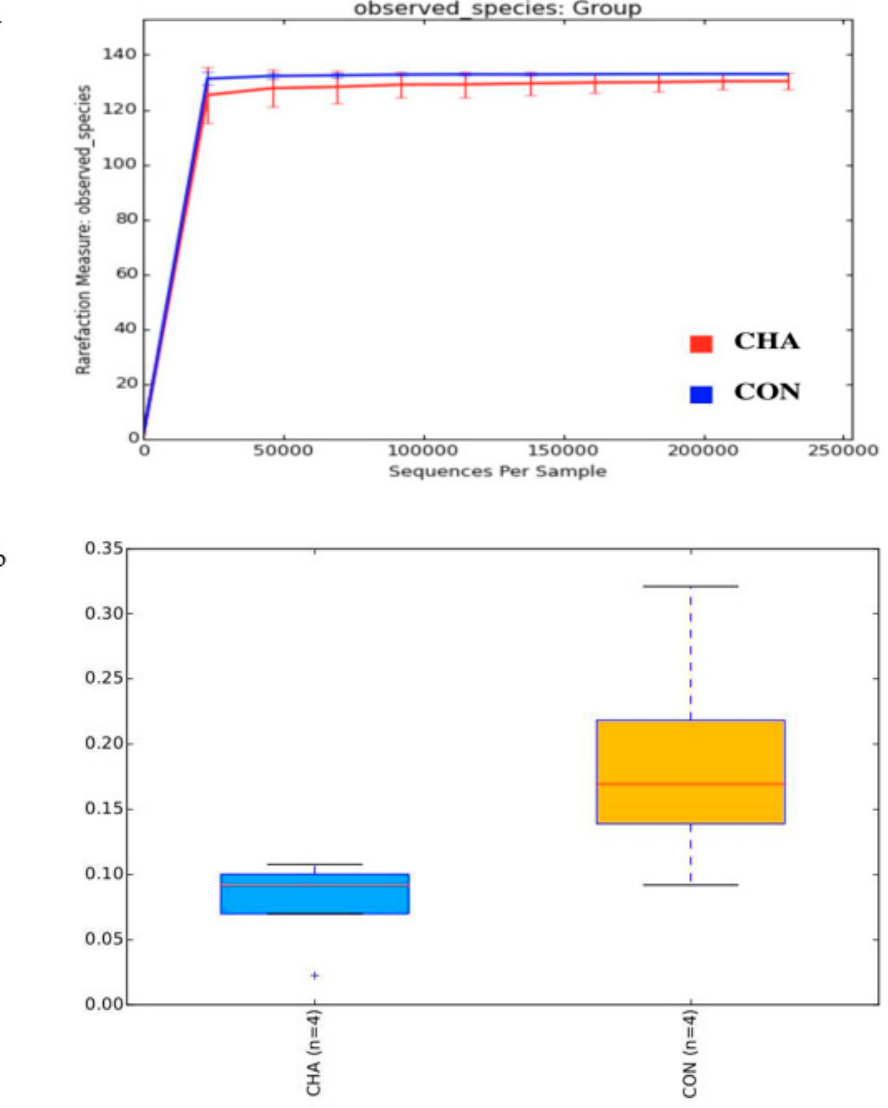
Figure 2. ( a ) Species richness (rarefaction curve) and ( b ) species evenness (Heip’s estimators) of the transcriptionally active microbial community in beef cattle during the acidosis challenge. CHA = corn-induced acidotic challenge, CON = control (no challenge).